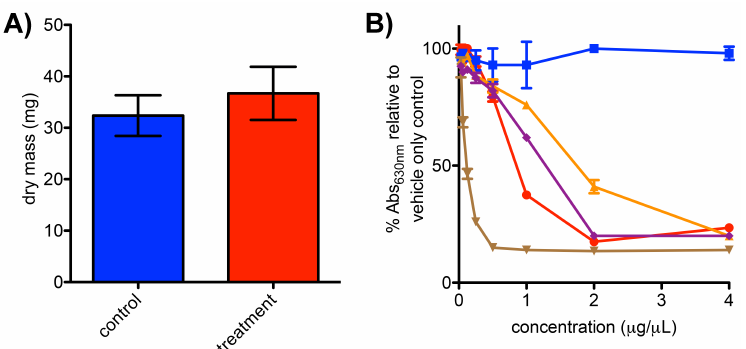
Figure 3. Evaluation of N. dassonvillei biomass and siderophore titer changes in response to fermentation in bipyridyl-containing media for seven days. ( A ) Dry mass of cell pellets from N. dassonvillei treatments fermented in 50 mL media with bipyridyl relative to controls fermented without bipyridyl. An unpaired t -test ( n = 4) revealed p = 0.23. ( B ) Comparison of siderophore activity across chemical extracts from N. dassonvillei culture types and media only controls. Decreased absorbance at 630 nm corresponds to increased siderophore concentration, as illustrated by desferrioxamine B positive controls (brown triangles). Blue squares denote activity of extracts from control N. dassonvillei grown in media without bipyridyl, while red circles indicate activity of N. dassonvillei treatments fermented with bipyridyl. These treatment extracts were markedly more active than those from bipyridyl-containing media only controls (orange triangles), supporting that N. dassonvillei produces siderophores. Comparable activities were observed for treatment extracts (red circles) and extracts formed by mixing extracts from bipyridyl-containing media with bipyridyl-free N. dassonvillei cultures (purple diamonds), suggesting that bipyridyl treatment does not dramatically upregulate siderophore production. Error bars indicate standard deviation for n = 4